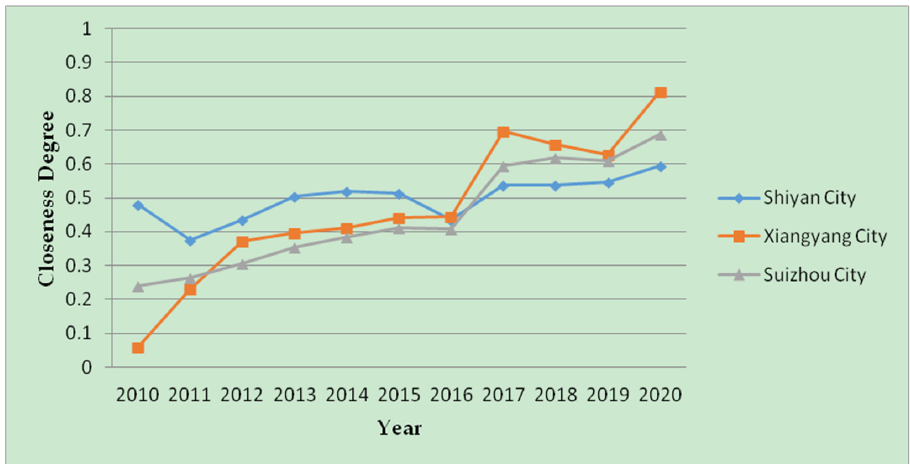
Figure 3. The closeness degree of the economic benefits of cultivated land use in three study areas during 2010–2020.